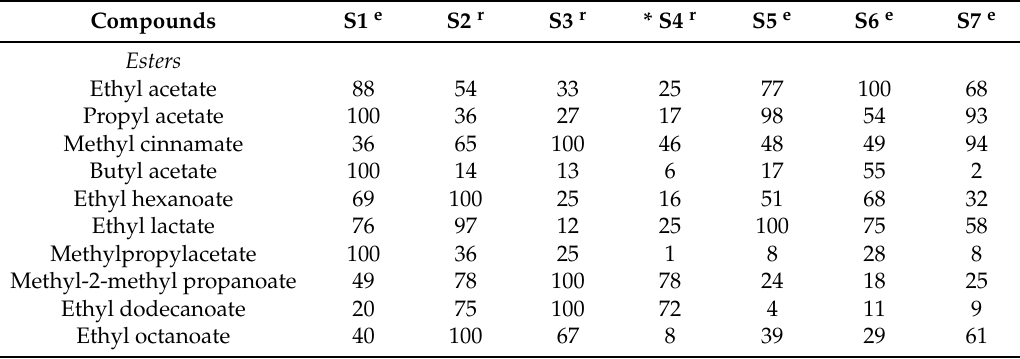
Table 3. Relative abundance (%) of fermentation products across all